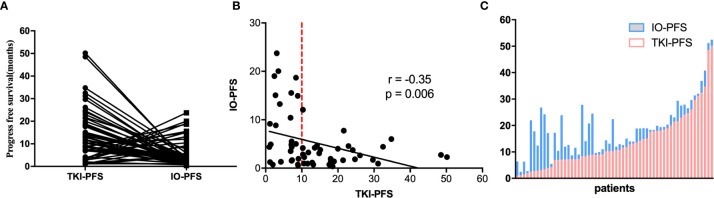
The correlation of TKIs-PFS with IO-PFS. (A) The one-to-one matched TKI-PFS in former line and IO-PFS in posterior line; (B) The distribution of TKIs-PFS and IO-PFS in cartesian coordinate system; (C) the waterfall plot of TKI-PFS with corresponding IO-PFS.